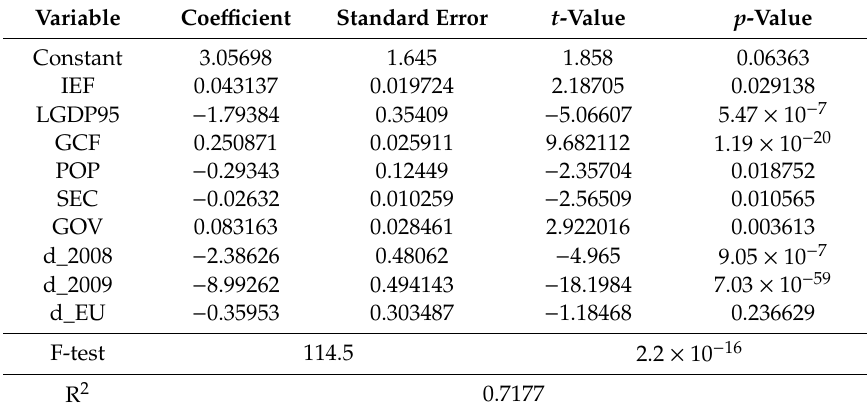
Table 6. Results from the reduced LSDV